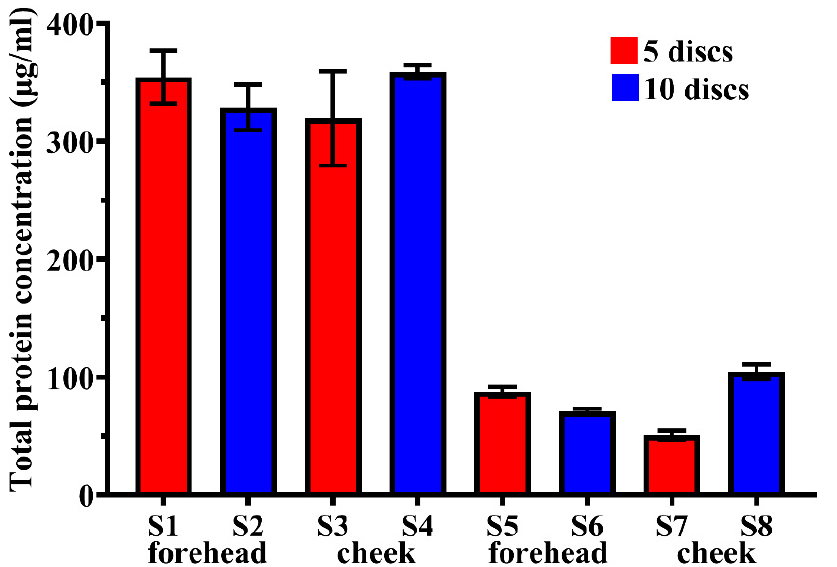
Figure 1. Total protein concentration of samples collected from forehead or cheek of healthy individuals. The ‘y’ axis indicates the protein concentration in samples obtained from forehead and cheek (S1–S4) of D1 volunteer and (S5–S8) of D2 volunteer shown on ‘x’ axis. The red bars represent mean ± SEM of the protein concentrations observed in samples obtained from pooling of 5 discs, while the blue bars show samples obtained from pooling of 10 discs.